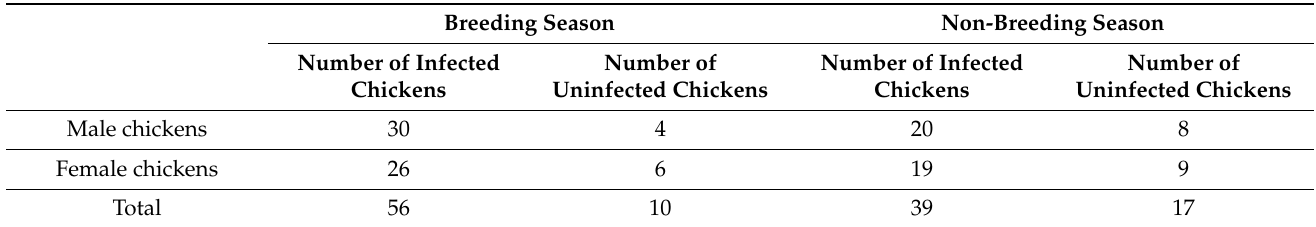
Table 2. Number of male and female chickens sampled in the breeding and non-breeding seasons. Breeding